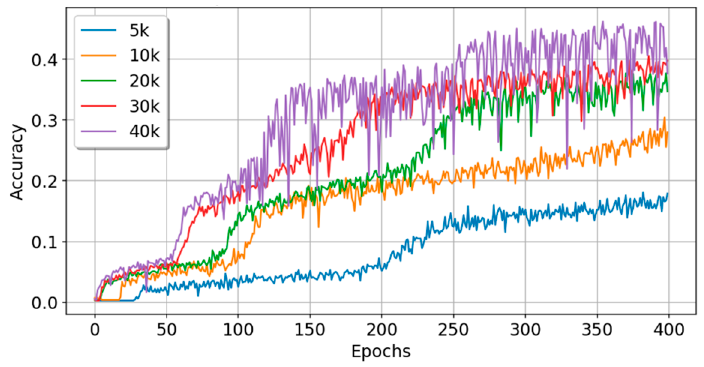
Figure 25. The performance of LSTM for different size data.